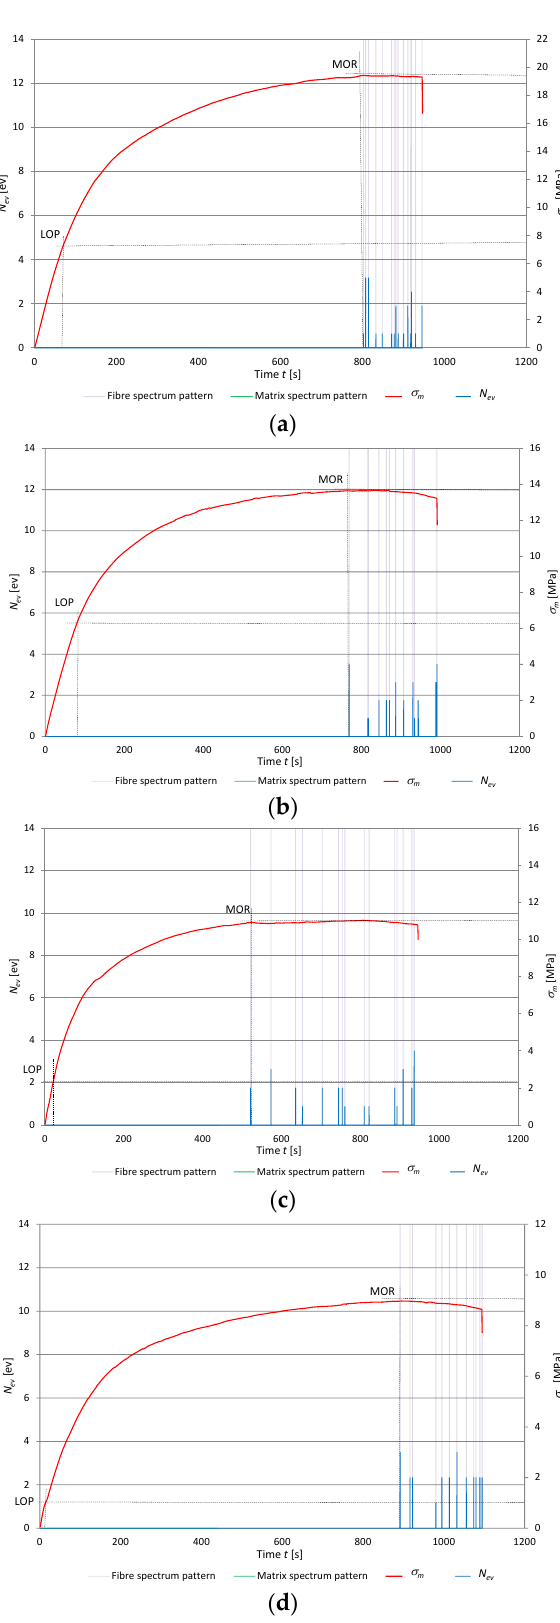
Figure 10. Events rate N ev and flexural stress σ m versus time for fiber cement boards stored in water for 24 h, with marked identified reference spectral patterns: ( a ) series A, ( b ) series B, ( c ) series C, ( d ) series D.